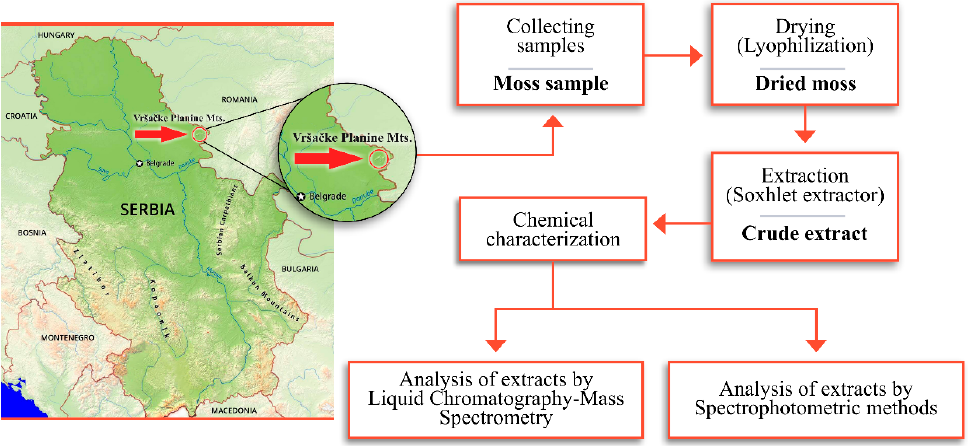
Figure 4. The position of the investigated collection area (Vršaˇcke Planine Mts.) in Serbia with illustrated steps in the preparation and characterization of the extracts.